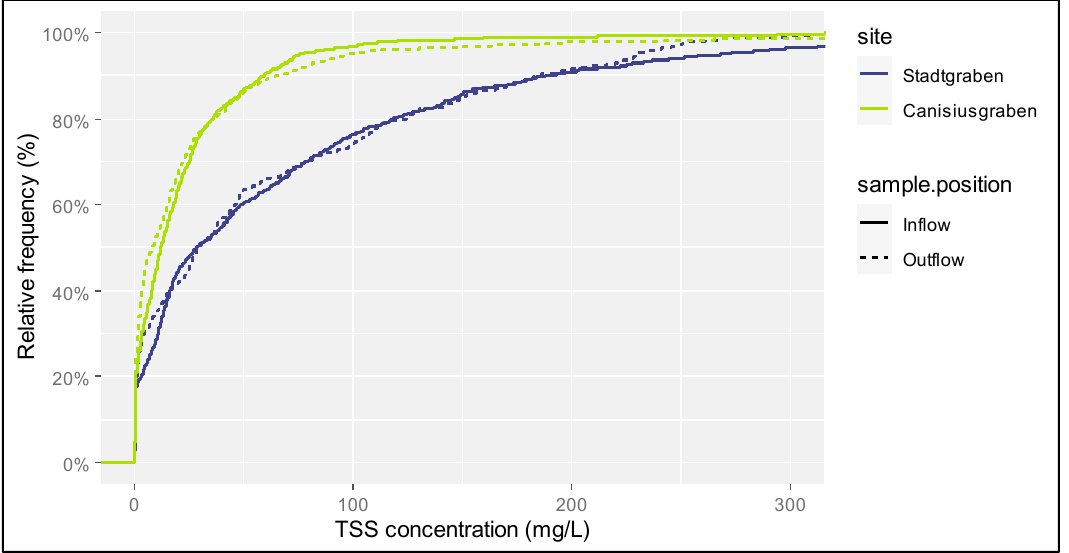
Figure 3. TSS63 ratio per composite sample bottle at SG during event sampling. Each bottle repre- sents a 10 min time step. With numbers of samples per boxplot: for inflow min = 14, and max = 19 and for outflow min = 6, and max = 8. Boxplots with whiskers for inflow and outflow ratios sum- marize the statistical description of all bottle samples and show mean, median, 0.25 and 0.75 per- centile, and 1.5 × inter-quartile range (IQR). Outliers are indicated as black dots.